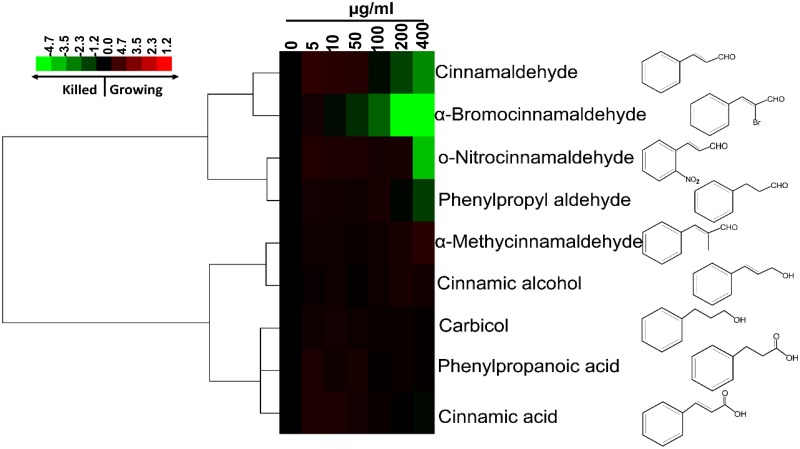
Hierarchical cluster analysis of the bactericidal effects of CA and its derivatives on E. coli cells in exponential growth phase.Cell survival percentage after treatment was calculated based on the colony counts on the LB agar plates. Resulting tree figure was obtained using Cluster 3.0 software and Java Treeview. The cluster color bar was shown as [log (cell survival percentage ×100)-2]. If the given amount of drug failed to completely inhibit the bacterial growth, the corresponding values in the bar would be positive in red color; If the given amount of drug showed the bactericidal effects, the corresponding values in the bar would be negative in green color.